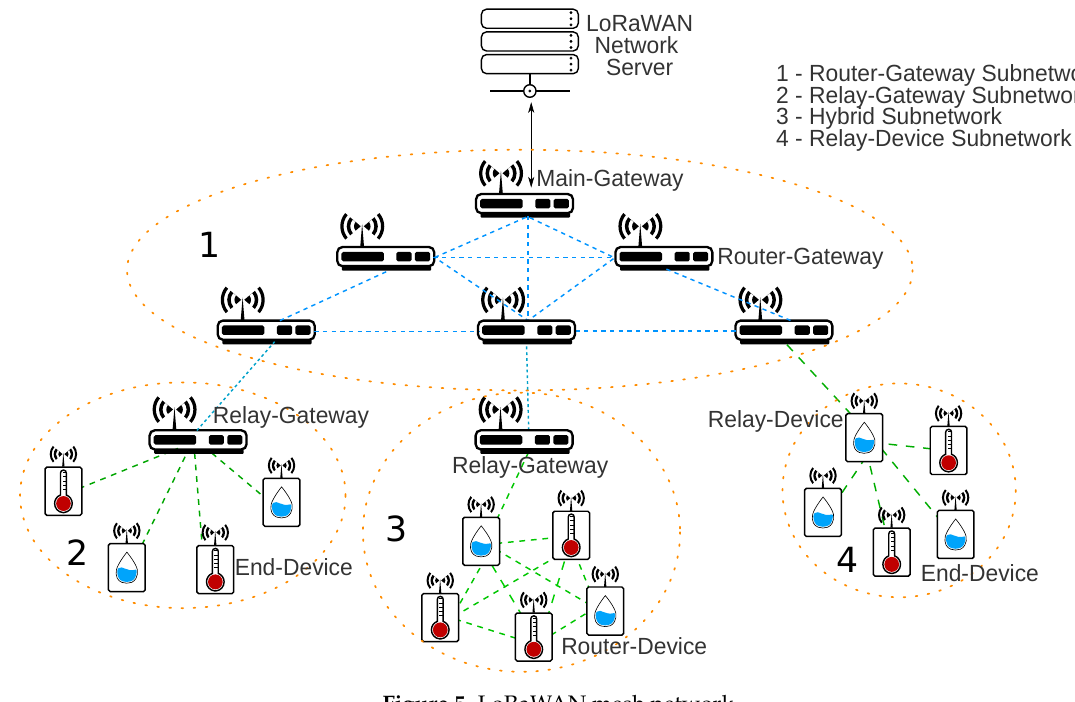
Figure 5. LoRaWAN mesh